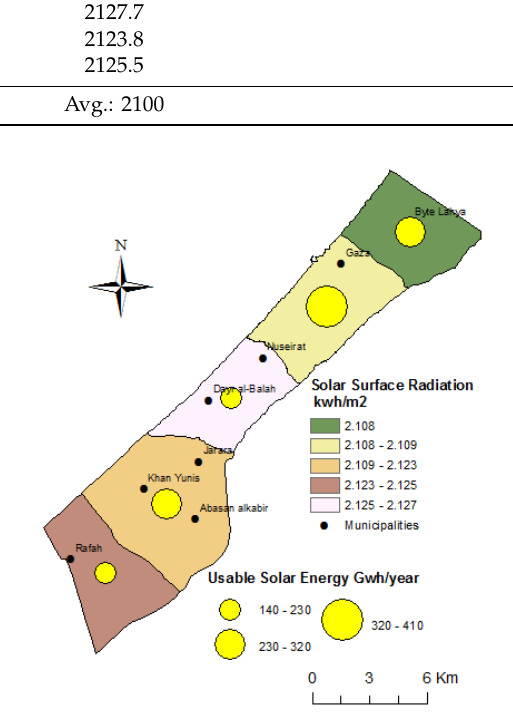
Figure 9. Solar surface radiation (kWh/m 2 ) and annual solar energy production (circles) for each